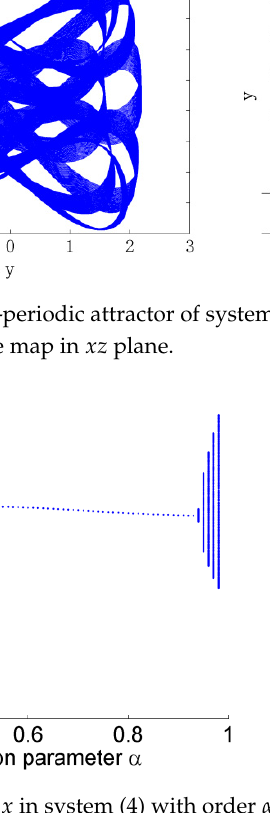
α= . ( a ) Phase trajectory diagram in